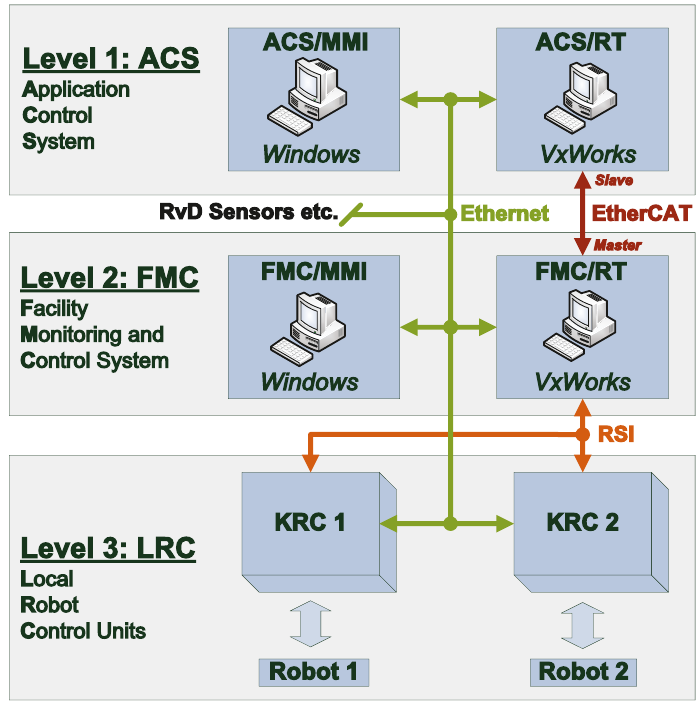
Figure 4. EPOS 2.0 control system